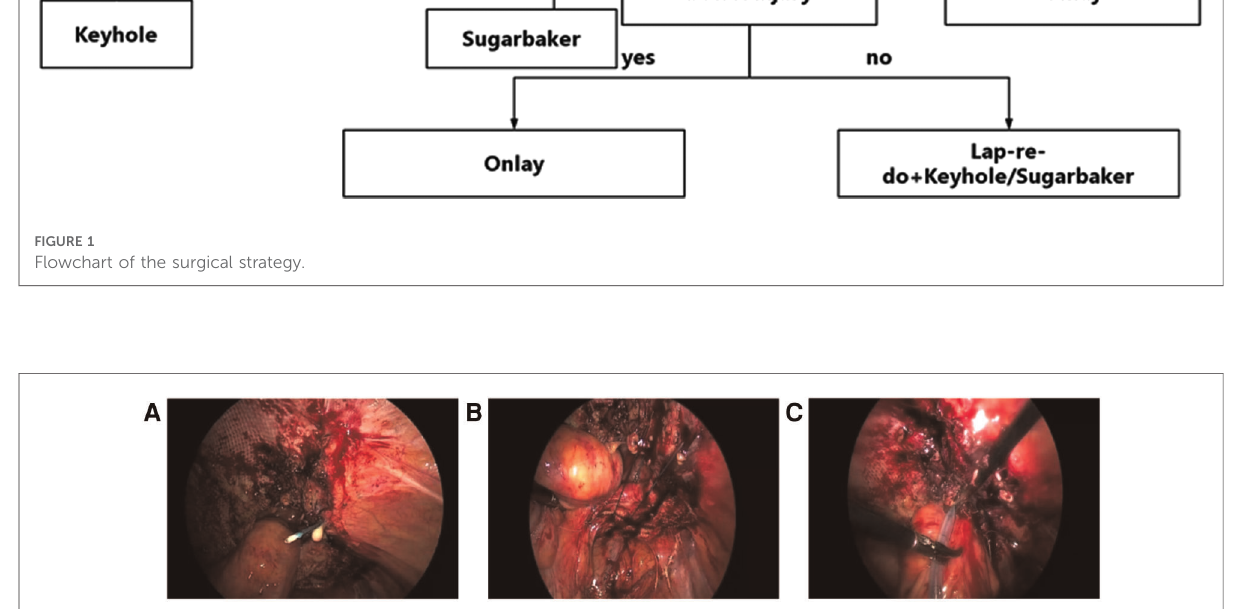
FIGURE 2 Simple suture repair ( A ) Discontinuous suture of hernia ring with hook needle, pus can be seen at the puncture; ( B ) Complete closure of the hernia ring; ( C ) Placement of drainage